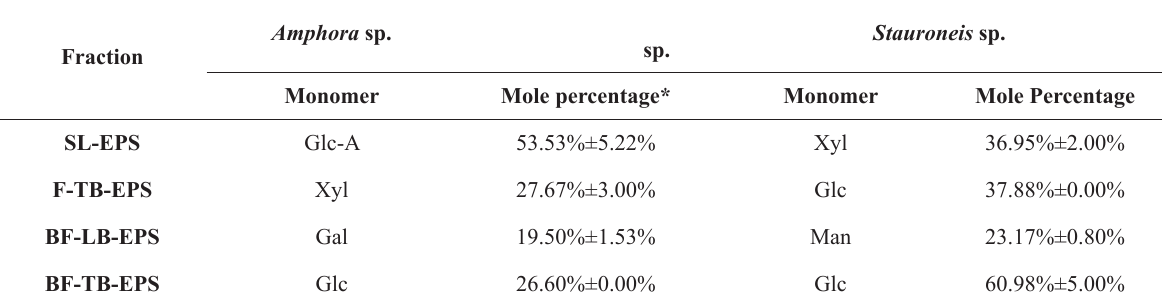
The most abundant monosaccharides in different EPS fractions from two diatoms. Amphora Fraction